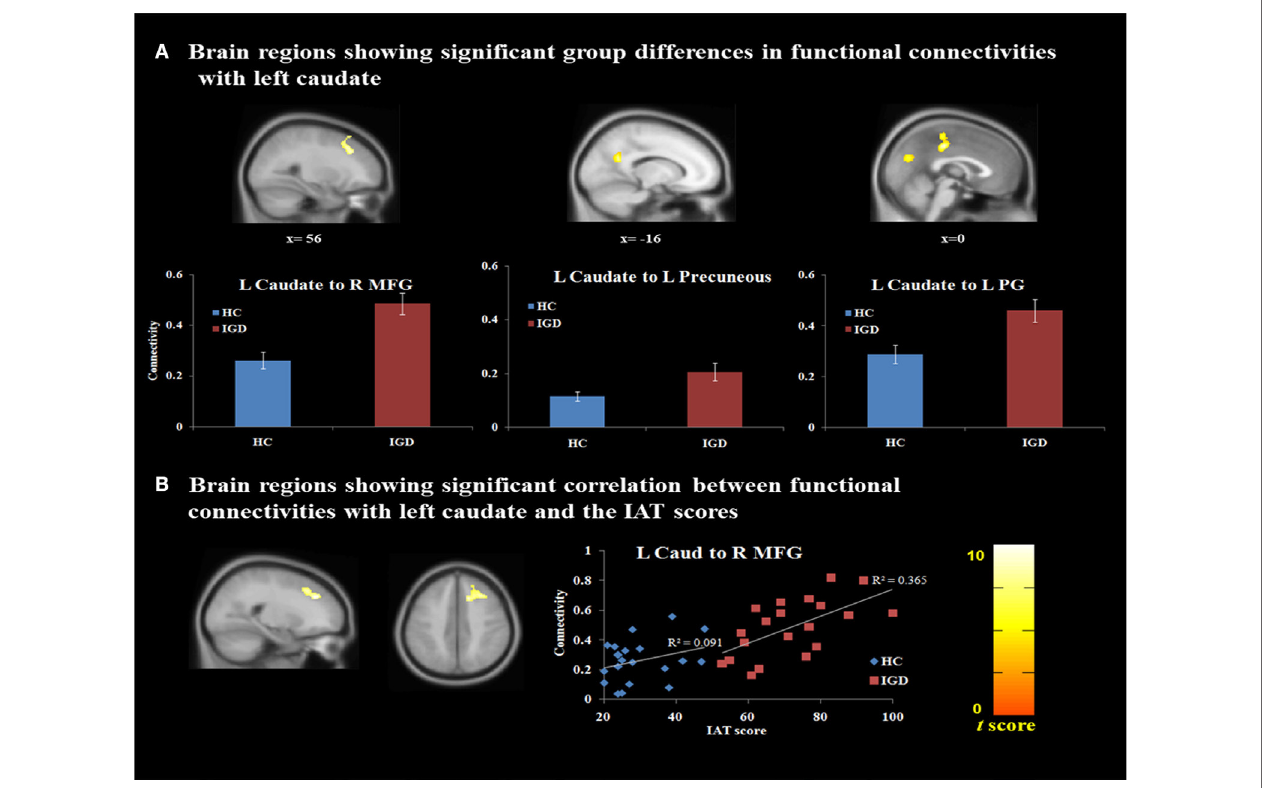
FigUre 2 | Functional connectivity analysis. (a) Different brain connectivity between the IGD group and HC ( p < 0.05, FDR corrected) (MNI coordinates: L caudate, − 9, 8, 15; R/L PCG, 0, -28, 44; R MFG, 35, 12, 40; L precuneus, − 16, − 56, 26). (B) Correlation analysis between IGD severity and the functional connectivity value ( p < 0.05, FDR corrected) (MNI coordinates: L caudate, − 9, 8, 15; R MFG, 22, 36, 34). Abbreviations: HC, healthy controls; IAT, Internet addiction test; IGD, Internet gaming disorder; L, Left; MFG, middle frontal gyrus; PG, postcingulate gyrus; R, right; FDR, false discovery rate; MNI, Montreal Neurological Institute; PCG, posterior cingulate